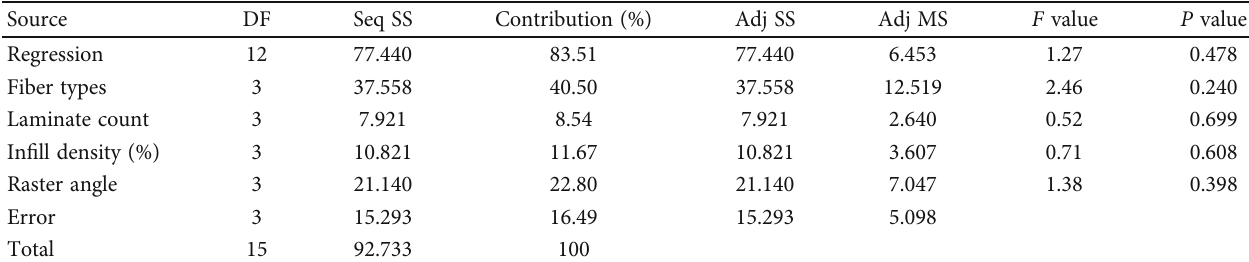
Table 5: Analysis of variance of fl exural strength.